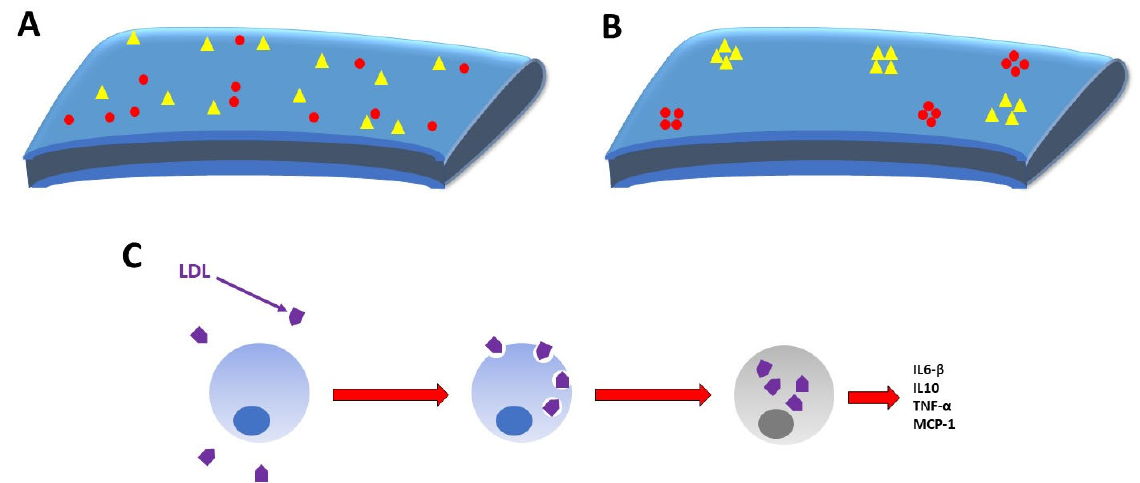
Figure 3. Epithelial cell surface membrane with ( A ) diffusely assorted ACE2 receptors (red circles) and furin (yellow triangles) and ( B ) increased furin and ACE2 receptor aggregation onto lipid rafts following Apo-E induced internalization of cholesterol. ( C ) Macrophages (blue) uptake oxidized LDL (purple), thus becoming foam cells (gray) which produce greater levels of circulating cytokines.